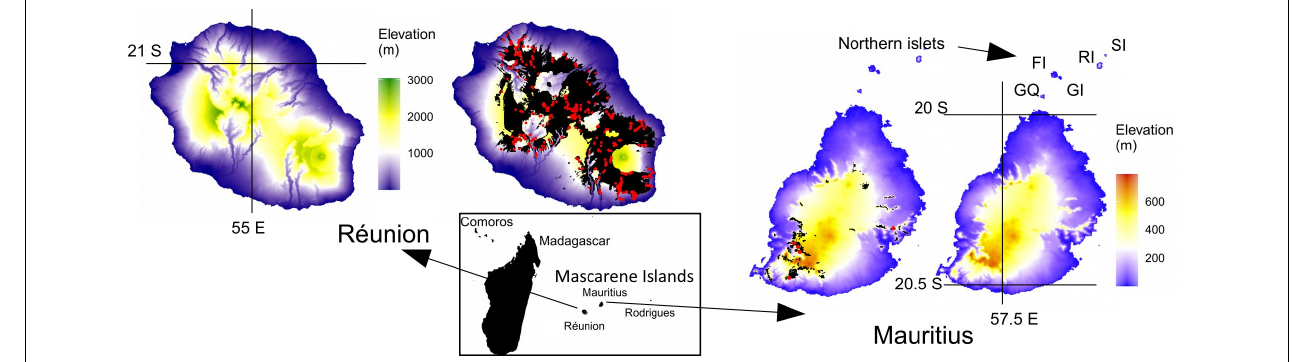
FIGURE 1 | Topography and native forest remnants of the two main islands of the Mascarenes. Réunion is a relatively recent high-elevation island with only one tiny islet, while geologically older Mauritius shows a much less rugged topography and a large number of islets. The northern islets that have played an important role for the conservation of several endemic reptiles are indicated by letters: from South to North, “GQ” Gunner’s Quoin, “GI” Gabriel Island, “FI,” Flat Island,” “RI” Round Island and “SI” Serpent Island. The small Pigeon House Rock is not visible on the map. These six islets are located between 4 km (Gunner’s Quoin) and 24 km (Serpent Island) from the mainland. Extant native forests and shrublands are shown in black. On both islands, they are mainly located at the highest elevations, but two native forest corridors between sea level and montane habitats still persist in the South-East and North on Réunion. Red points display the location of historical surveys used for analyses of plant diversity (430 and 5 plots on Réunion and Mauritius,